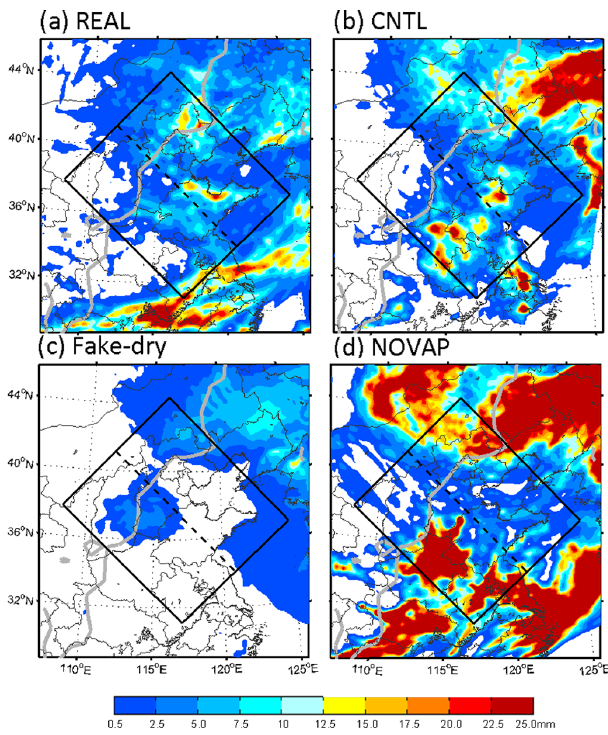
Fig. 4. Mean daily precipitation (mm) for (a) REAL; (b) CNTL; (c) Fake-dry; (d)